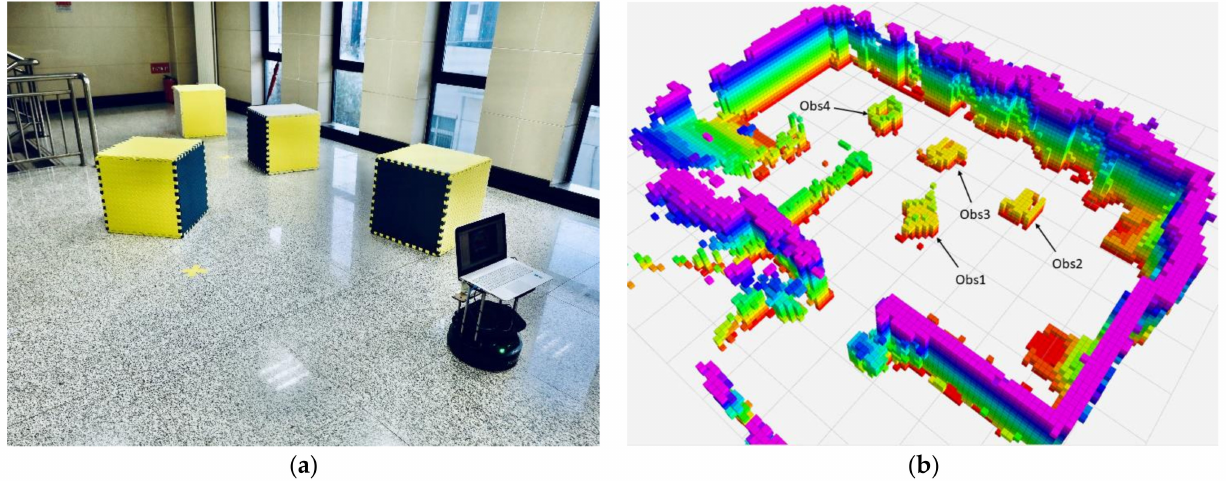
Figure 10. ( a ) Photo of the actual testing environment and ( b ) occupancy grid map of the environment built by our